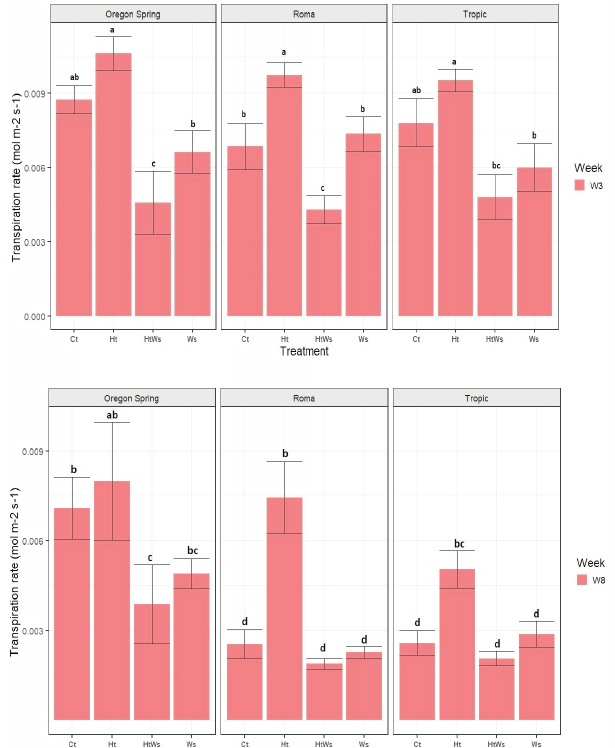
Fig. 1 ­ Transpiration rate (mol m ­2 s ­1 ) of three tomato varieties (Oregon Spring, Roma and Tropic). The treatments consi­ st of Control (Ct), Water stress (Ws), Heat + Water stress (HtWs) and Heat (Ht). W3 and W8 = weeks of treatments imposition with measurements. Bars with the same let­ ter are not significantly different at P<0.05 according to Turkey's